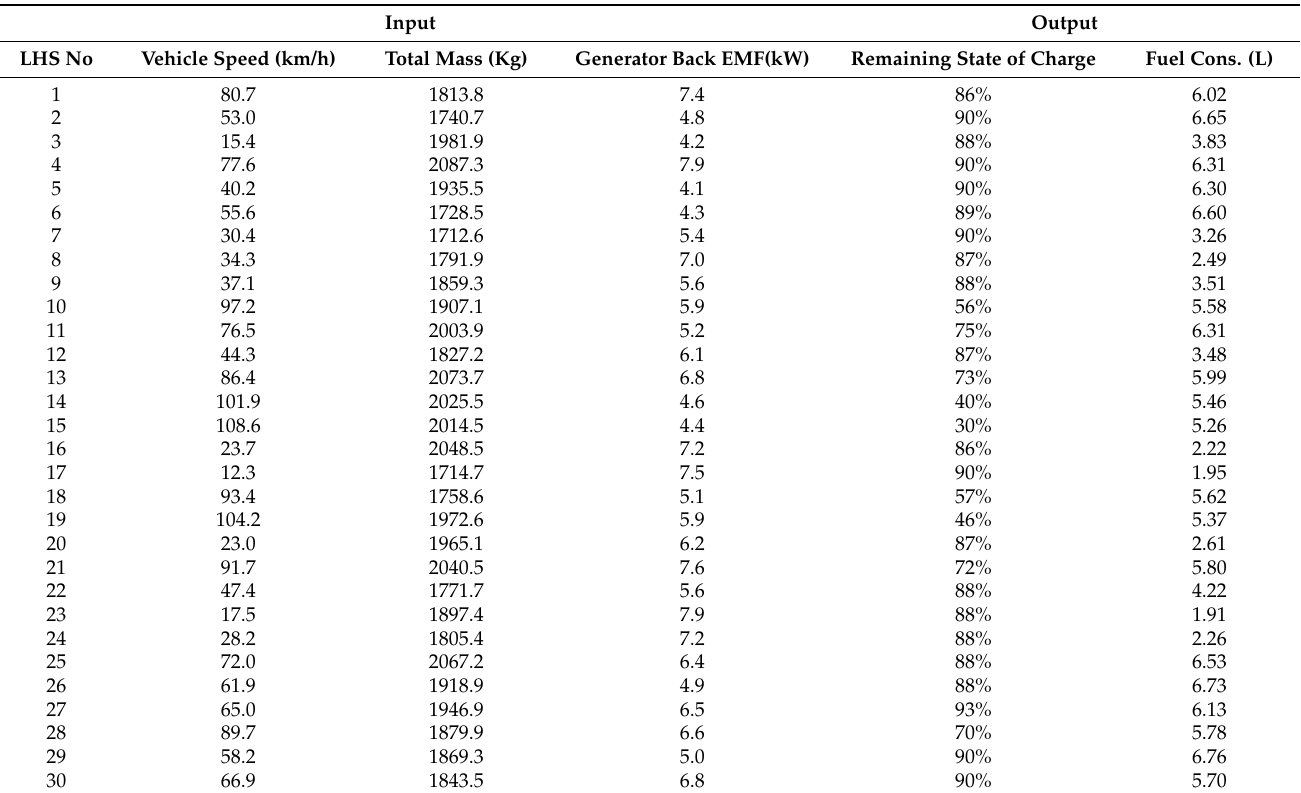
Table 2. Data samples generated with LHS